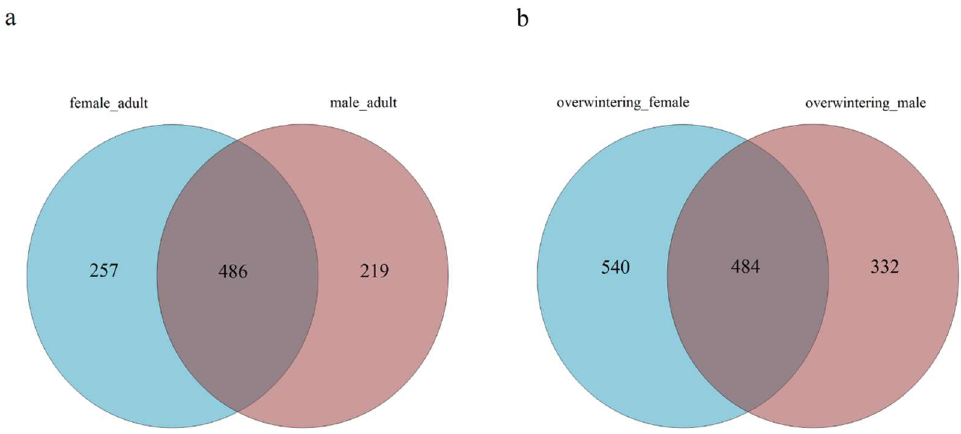
Table 4. Biodiversity index values of T. klimeschi in different sexes.